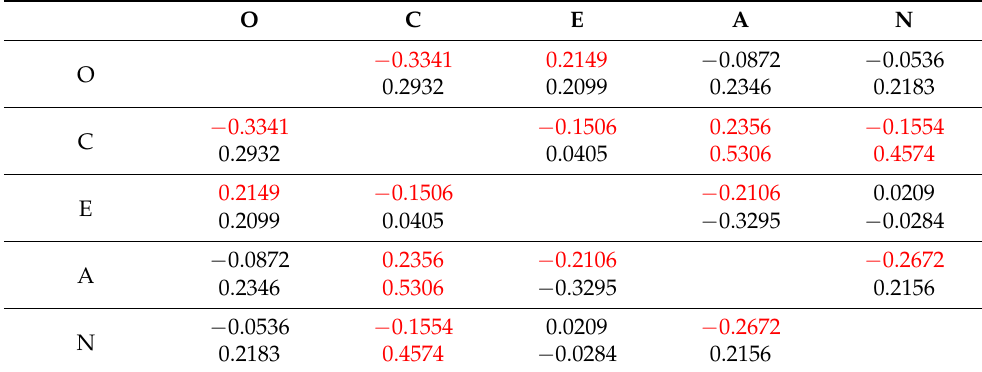
Figure 3. Average values of the OCEAN traits. Table 3. Correlation coefficients between the OCEAN